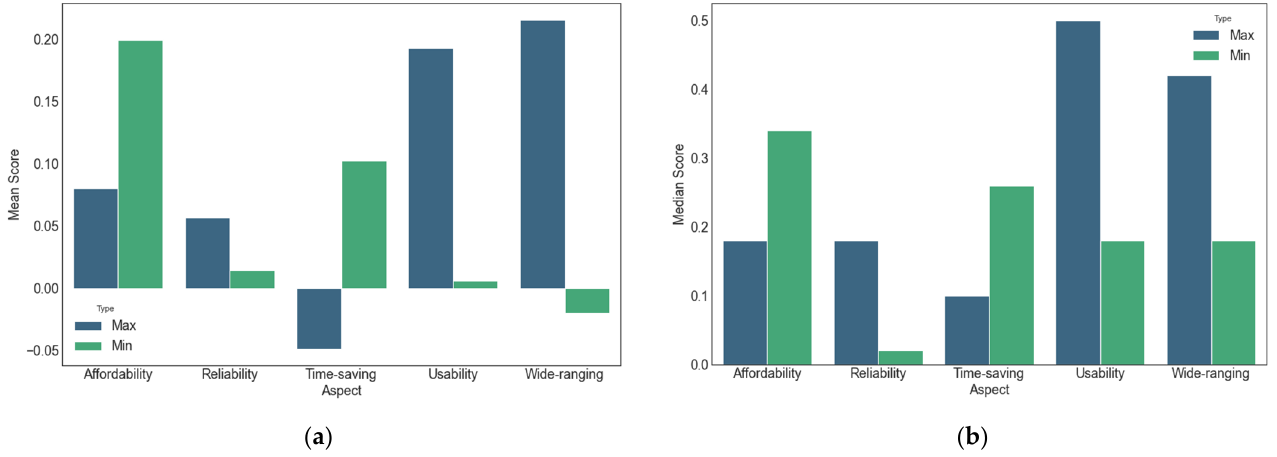
Figure 9. ( a ) Correlation of user aspects importance with the mean e-commerce awareness score; ( b ) correlation between user aspects importance with the median e-commerce awareness score.